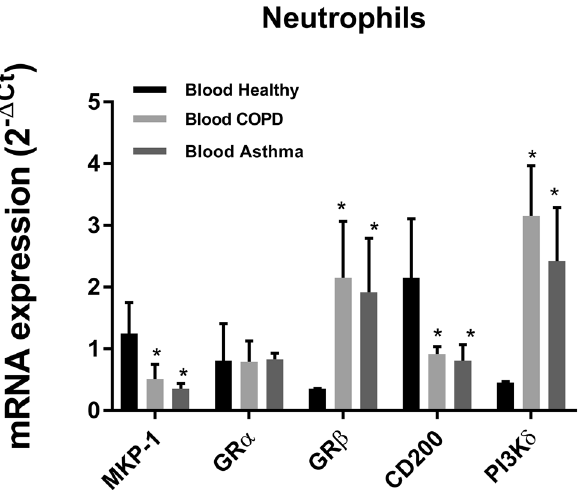
Figure 7. Basal corticosteroid dependent gene expression. Basal gene expression of corticosteroid anti- inflammatory genes (MKP-1, GRα and CD200) and corticosteroid inhibitor genes (PI3Kδ and GRβ) in peripheral blood neutrophils from healthy (n = 23), COPD (n = 23) and severe asthma patients (n = 21). Relative quantification was determined with the 2 −ΔCt method. Results are expressed as mean ± SD. *p < 0.05 vs.